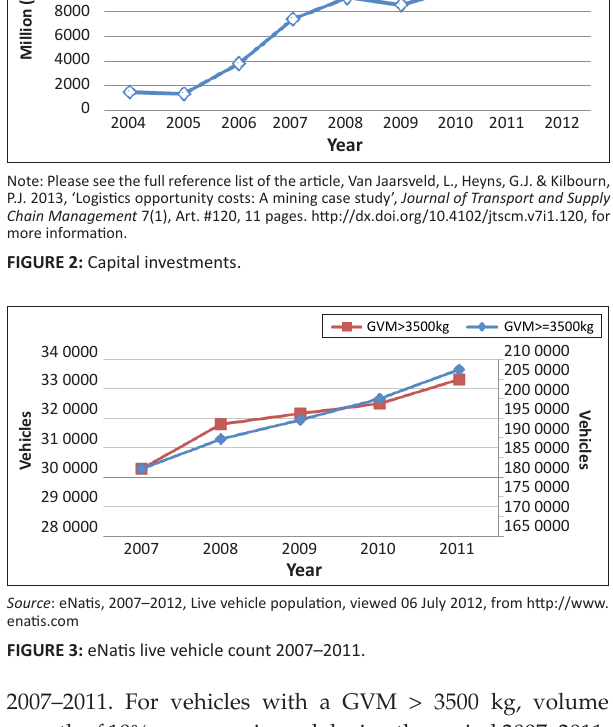
FIGURE 3: eNatis live vehicle count